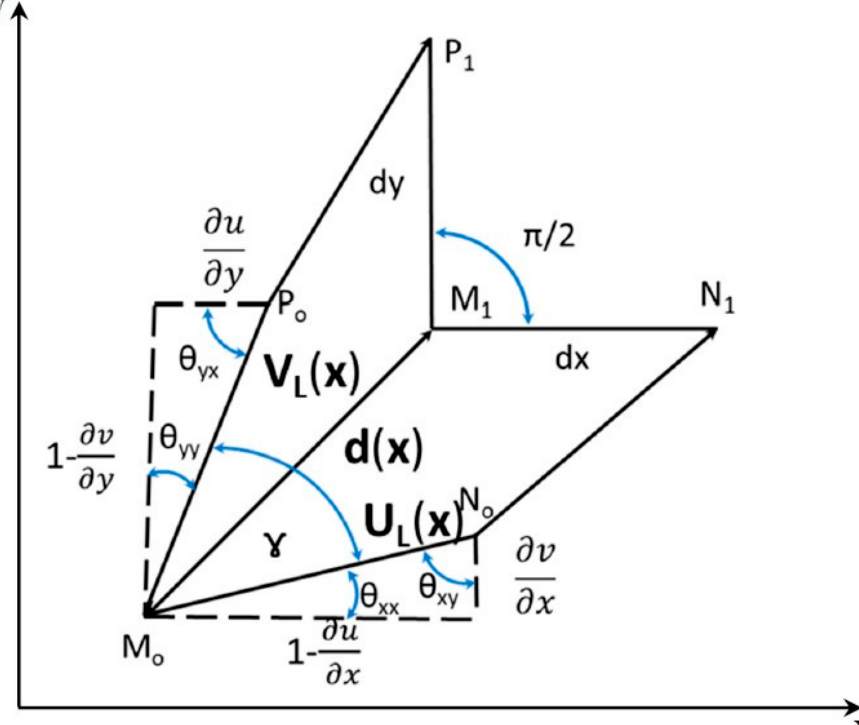
Figure 5. Di ff erential geometry description of the local transformations entailed by the applied deformation to a continuum medium. The figure illustrates the 2D